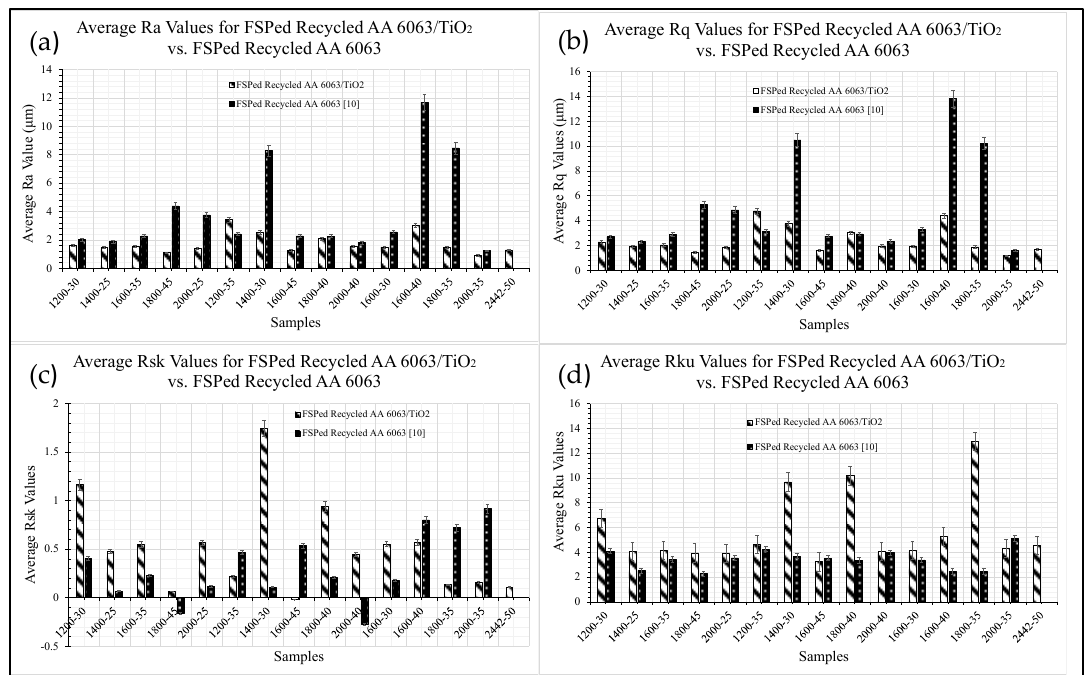
Figure 14. Stir zone microhardness of FSPed recycled AA 6063/TiO 2 vs. FSPed recycled AA 6063 and substrate material.